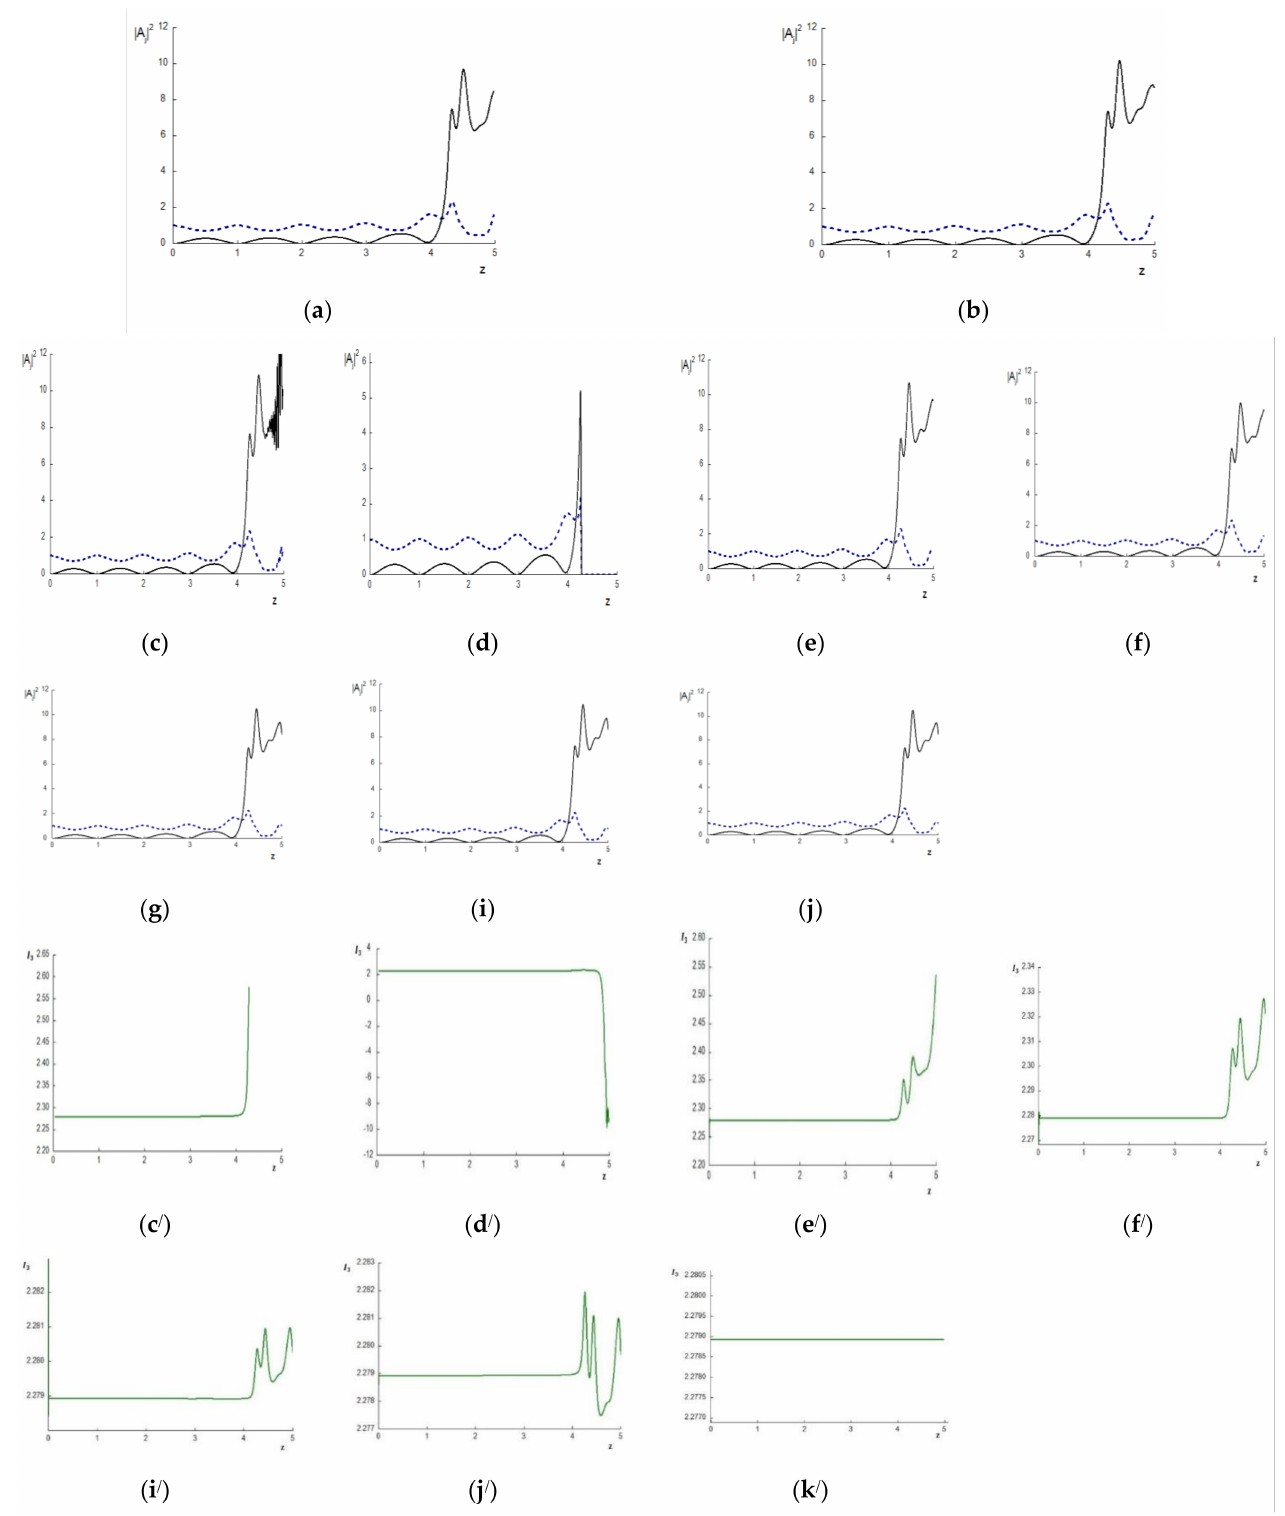
Figure 7. The intensity evolution at the pulse center ( t = 0.5 L t ) ( a – f ) for the BW (dashed line) and the TH wave (solid line) and the Hamiltonian deviation ( c / – f / ,i / – k / ) computed using the CFDS-I3 ( a , b , g , k / ), the ISSM ( c , e , I , c / , e / , i / ), and the SSMRK ( d , f , j , d / , f / , j / ) for mesh step h = 0.02 ( a , c , d , c / , d / , k / ); 0.0125 ( b , e , f , e / , f / ); 0.0025 ( g , i , j , i / , j /